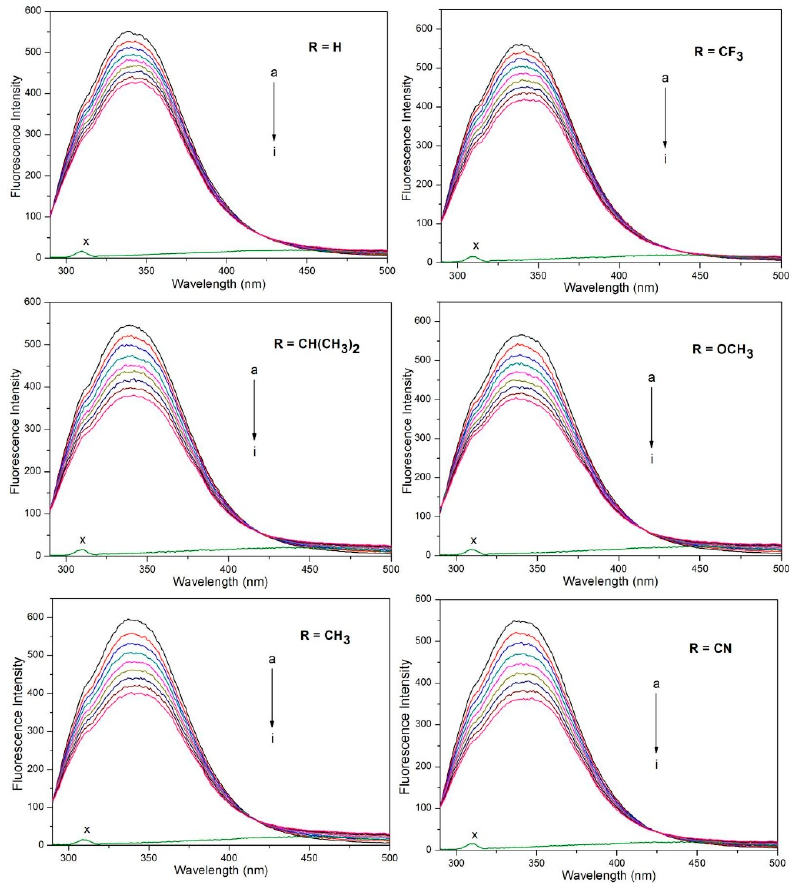
Figure 2. Fluorescence quenching spectra of HSA in the presence of different concentrations of PDQL at 298 K. λ ex = 280 nm; the HSA concentration was 1.0 × 10 − 6 M; (a–i) PDQL concentrations (×10 − 6 M) were 0.000, 1.333, 2.667, 4.000, 5.333, 6.667, 8.000, 9.333 and 10.667, respectively. (x) 1.0 × 10 − 6 M PDQL only.